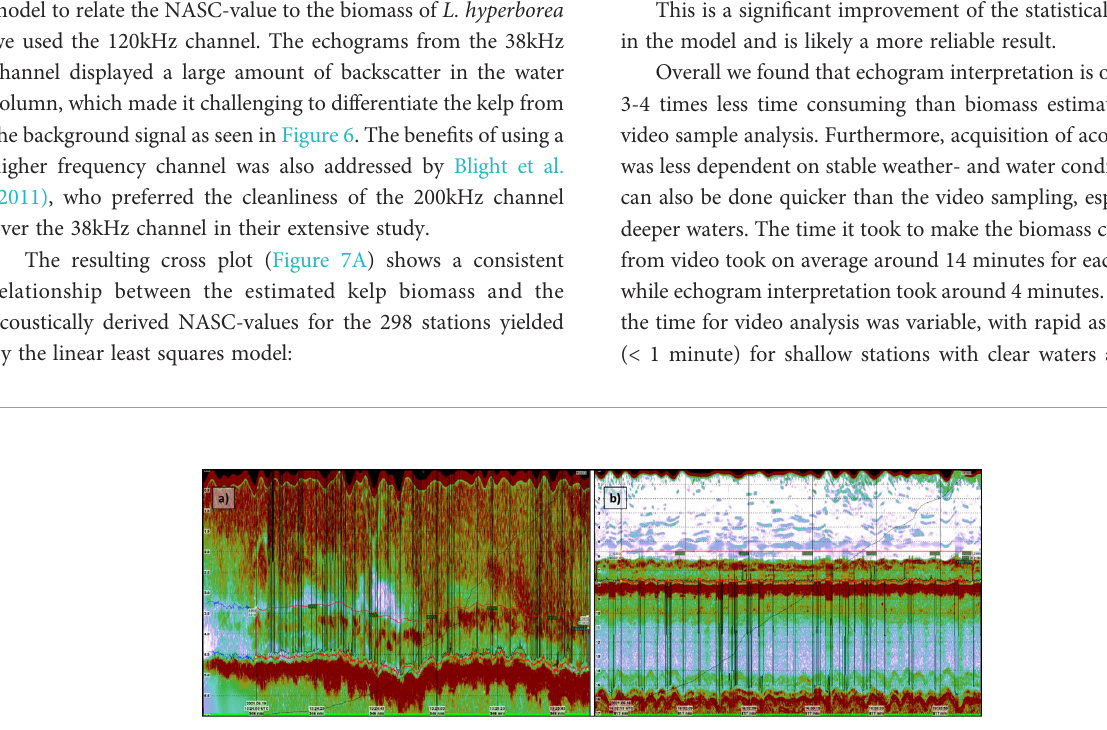
we used the 120kHz channel. The echograms from the 38kHz channel displayed a large amount of backscatter in the water